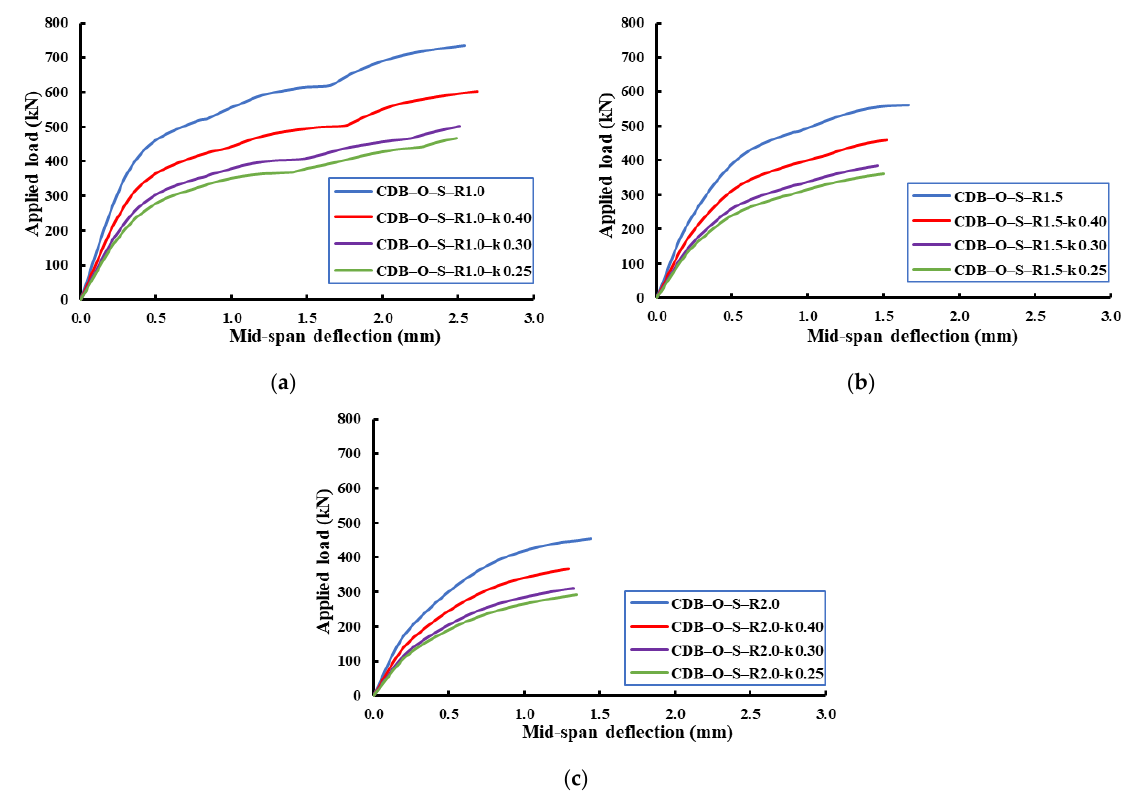
Figure 20. Effect of the load distribution factor on load–mid-span-deflection relationships of the strengthened RCCDBs with different ratios of the opening dimensions. ( a ) Opening ratio of 1.0; ( b ) opening ratio of 1.5; ( c ) opening ratio of 2.0. Table 8. Effects of the load distribution factor on the FE ultimate capacities and mid-span deflec- tions.